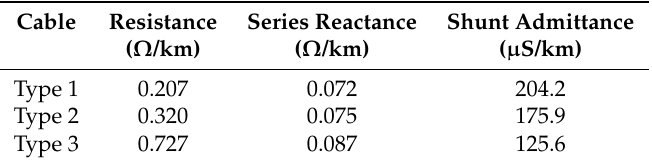
Table 2. Cable parameters of the LV grid.